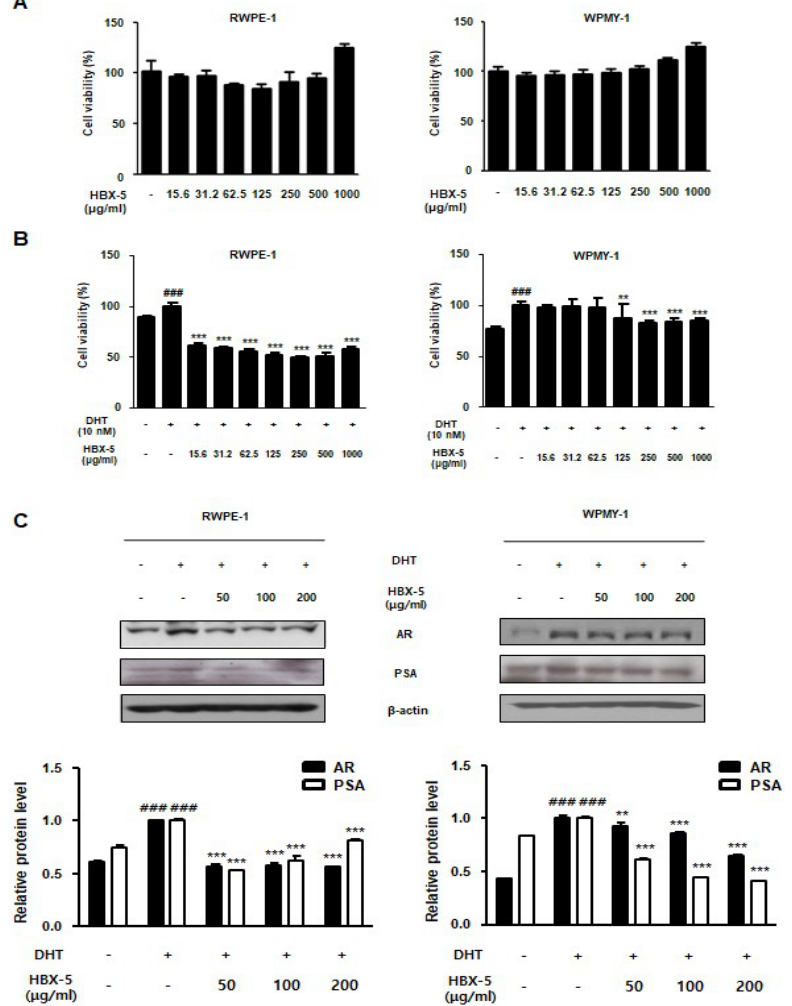
Figure 9. Effect of HBX-5 on the expression of BPH-related protein in RWPE-1 cells and WPMY-1 cells. ( A ) Effect of HBX-5 on the cell viability in RWPE-1 cells and WPMY-1 cells. RWPE-1 cells and WPMY-1 cells were treated with 15.6–1000 µ g/mL of HBX-5 for 24 h. ( B , C ) The normal human prostatic epithelial cell line, RWPE-1, and normal human prostatic stromal cell line, WPMY-1, were treated with 10 nM DHT for 72 h and 24 h respectively, with or without HBX-5 (50–1000 µ g/mL). ( B ) Inhibitory effect of HBX-5 on cell proliferation in DHT-stimulated prostate cells. ( C ) Anti-BPH effect of HBX-5 in DHT-stimulated prostate cells. The expression levels of AR and PSA were determined by western blotting using specific antibodies. β -actin was used as an internal control. The protein band densities were determined by densitometric analysis. Values represent mean ± S.D. of three independent experiments. ( ### p < 0.001 vs. Control group; *** p < 0.001 vs. DHT-stimulated group).